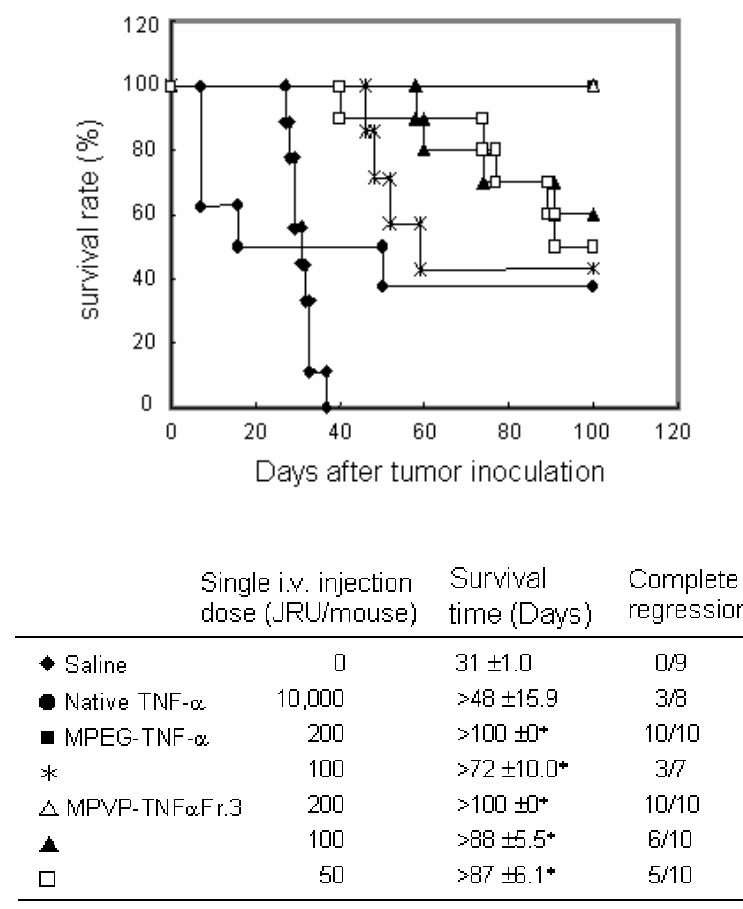
Figure 5. Antitumor effect of PVP-TNF- α by scheduled administration on survival days after Meth-A tumor inoculation. Meth-A-bearing BALB/c mice were given samples on days 7, 10, 14 and 17 after tumor inoculation. Complete regression was defined when tumor was not regrown for >100 days. Statistical significance compared with saline control: ∗ P <